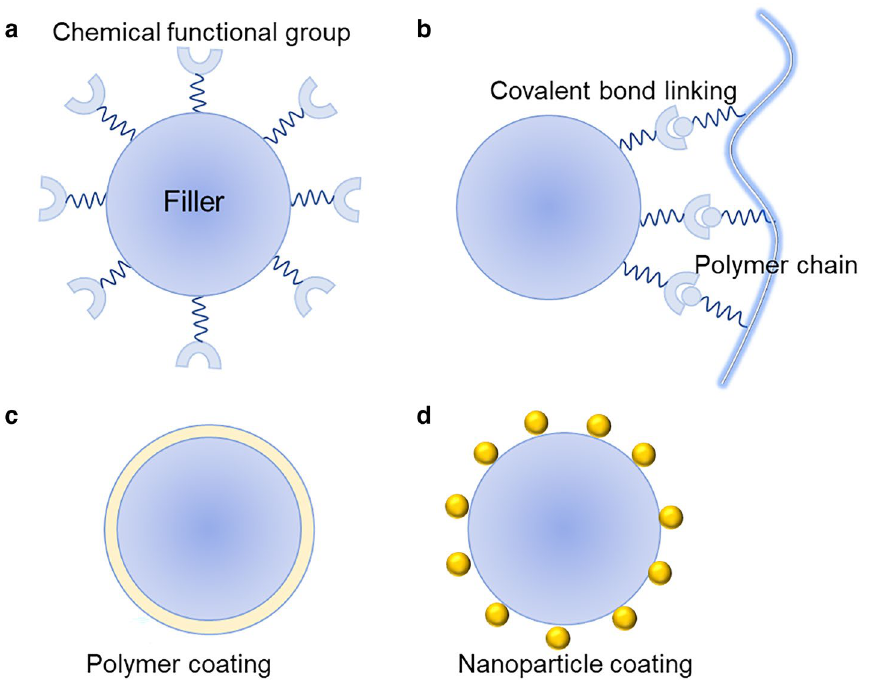
Fig. 10 Effective methods to reduce the ITR. a chemistry modification of filler surface, b constructing covalent bonds between filler and poly‑ mer or filler and filler, c coating polymer layer on the surface of fillers, and d constructing “bridge” structure using